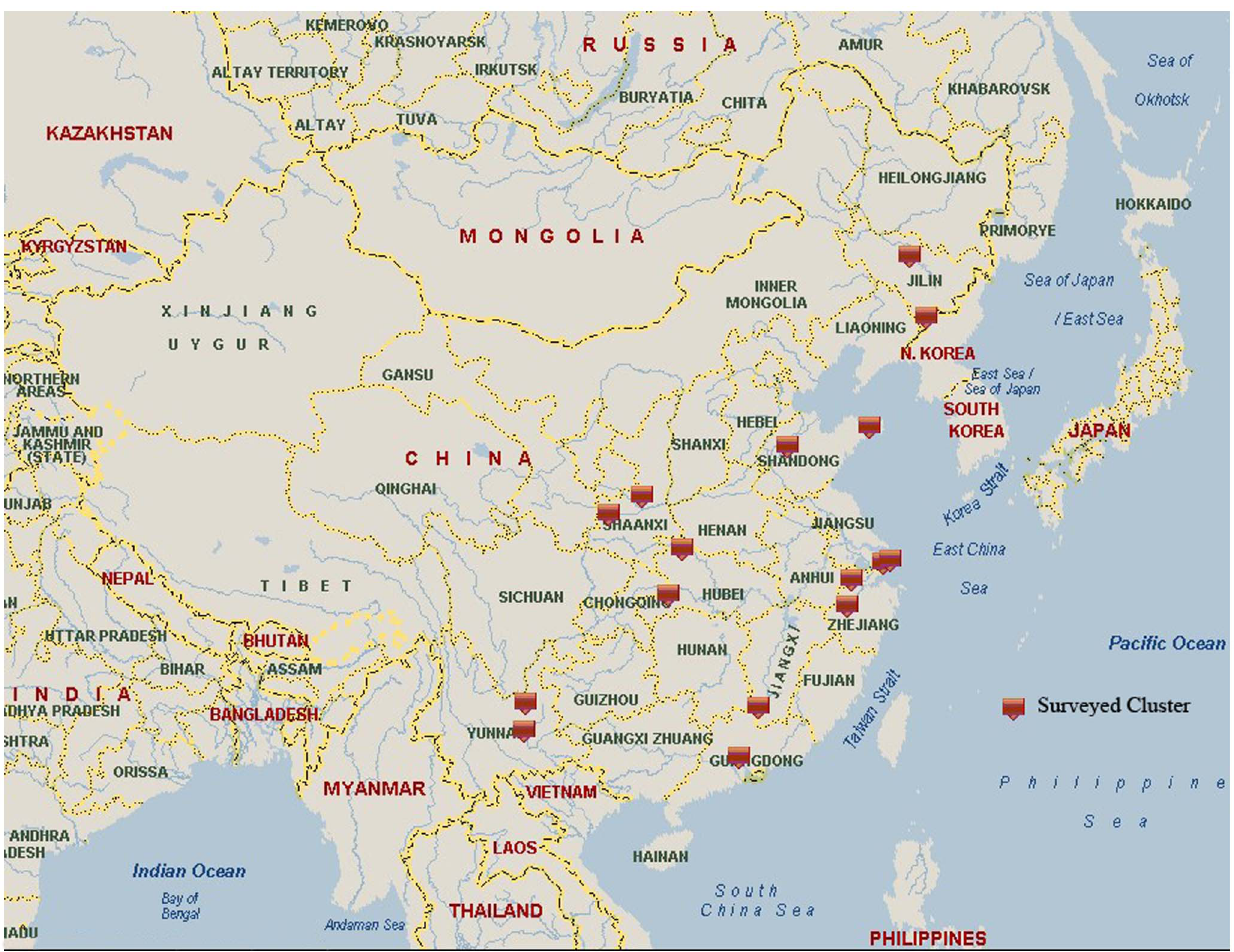
Figure 1. SAGE-China Wave 1 sample distribution.